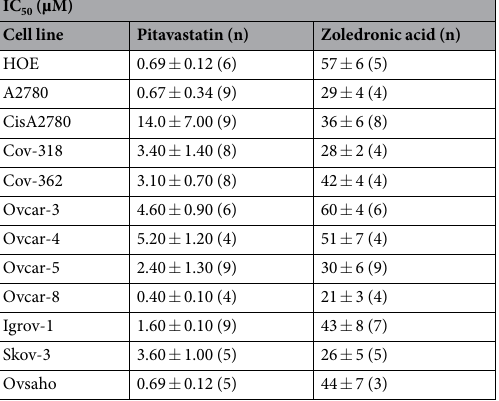
Table 1. Single agent potency of pitavastatin and zoledronic acid in cell growth assays. Cells were exposed to a range of concentrations of pitavastatin or zoledronic acid for 72 hr, except for the slow growing cell lines Cov-318 and Cov-362 (120 hr). The numbers of surviving cells were estimated by statin with SRB. IC 50 s (mean ± S.D.) were calculated from the indicated number (n) of